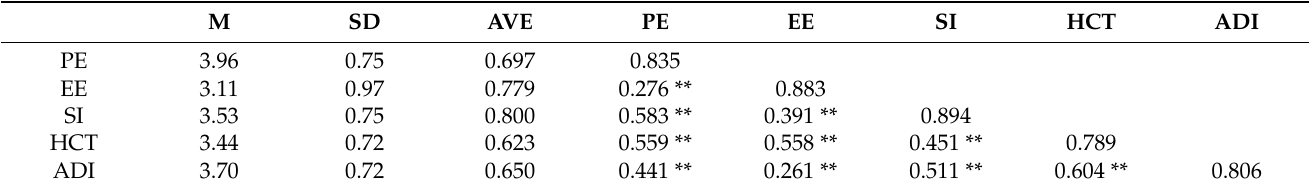
Table 3. Descriptive statistics and correlation among variables (N = 343).